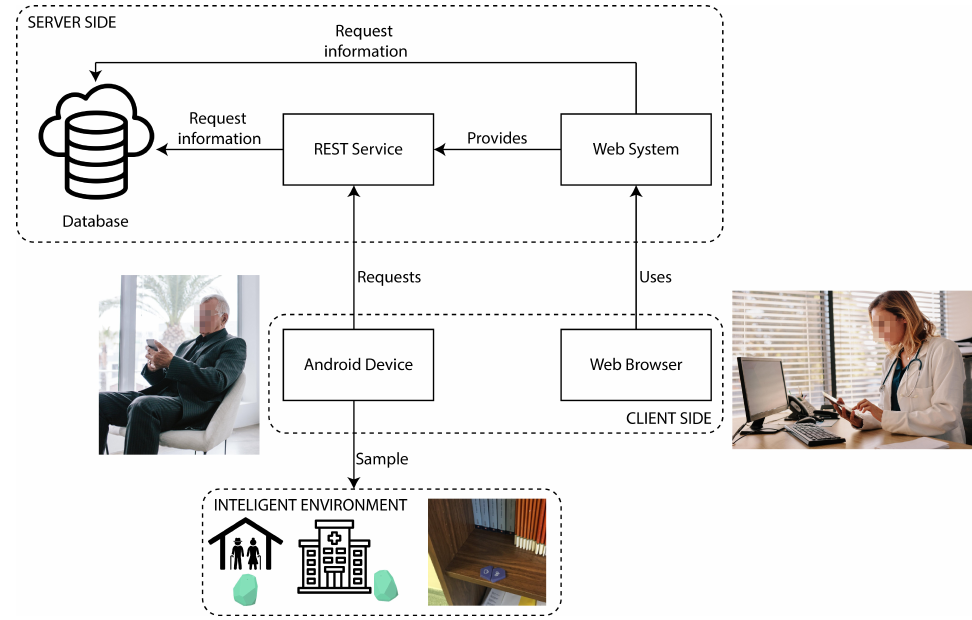
Figure 8. UJAmI Location